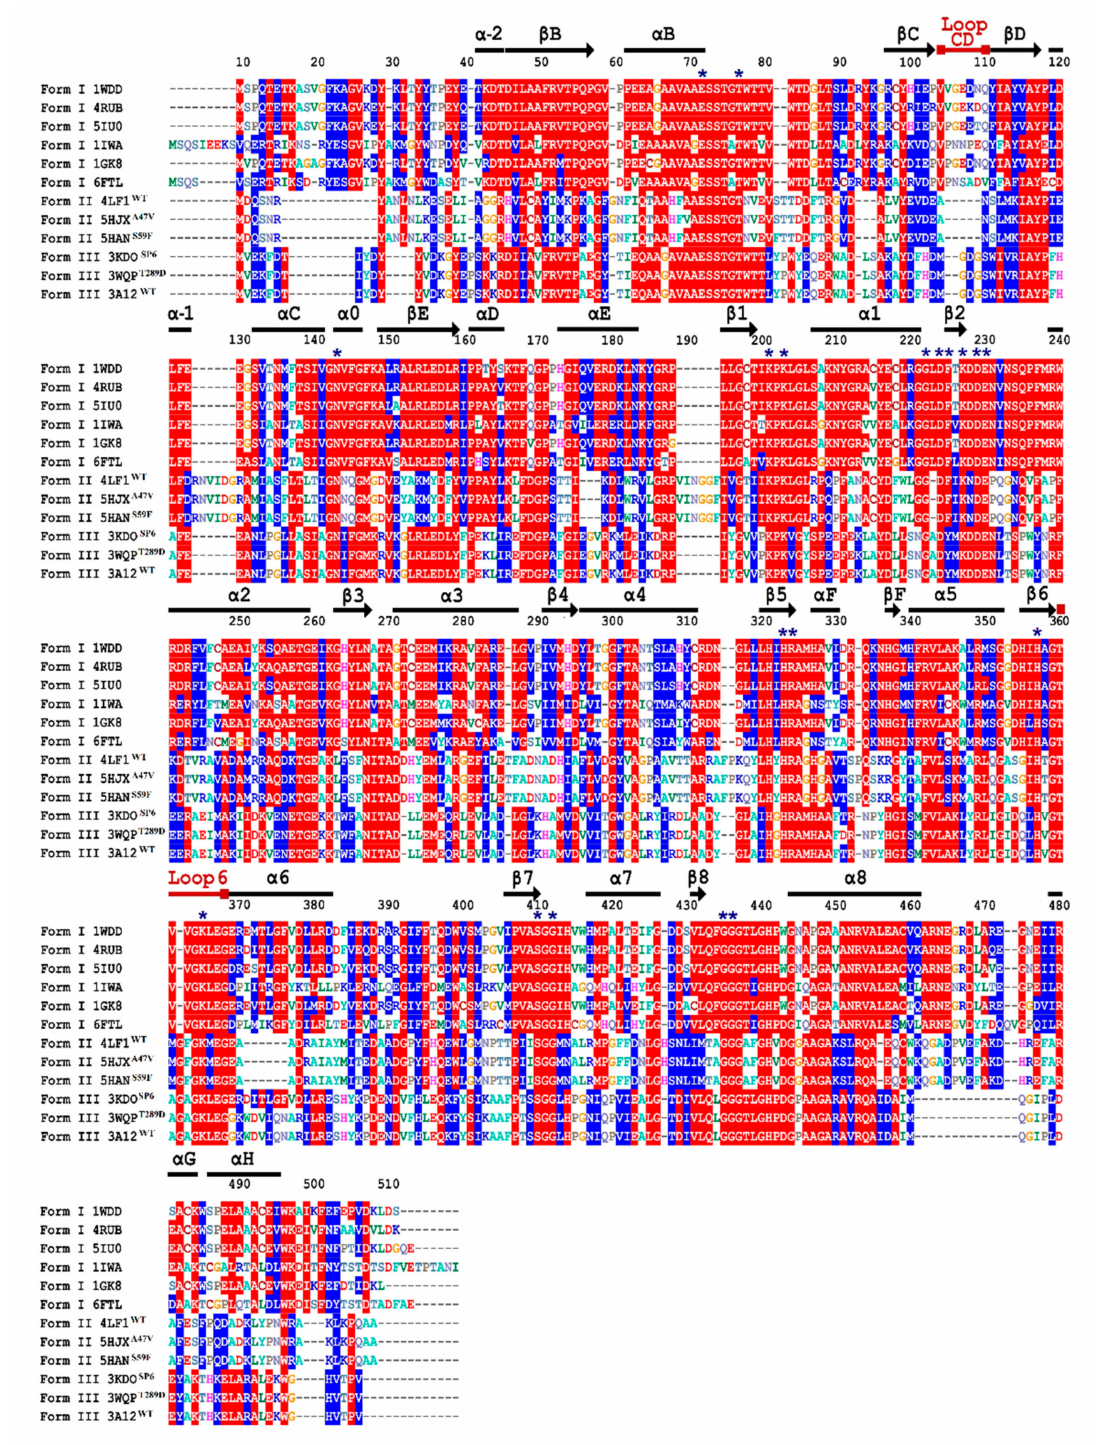
Figure 3. Multiple sequence alignment based on the structure of three isoforms of RuBisCO. Isoform I: O. sativa (1WDD), N. tabacum (4RUB), A. thaliana (5IU0), C. reinhardtii (1GK8), G. partita (1IWA) and S. marinoi (6FTL). Isoform II: 1 wild-type (4LF1 WT ) and 2 mutants (5HJX A47V and 5HAN S59F ) of R. palustris . Isoform III: 1 wild-type (3A12 WT ) and 2 mutants (3KDO SP6 and 3WQP T289D ) of T. kodakarensis . Amino acid residue numbers are shown at the top of the sequence. Secondary structural elements, such as α -helices (bars) and β -strands (arrows), are shown in the figure. With an asterisk is depicted, it indicates mechanically important active site residues. Red background shading represents identical amino acids, blue shading designates similar amino acids while white shading indicates no